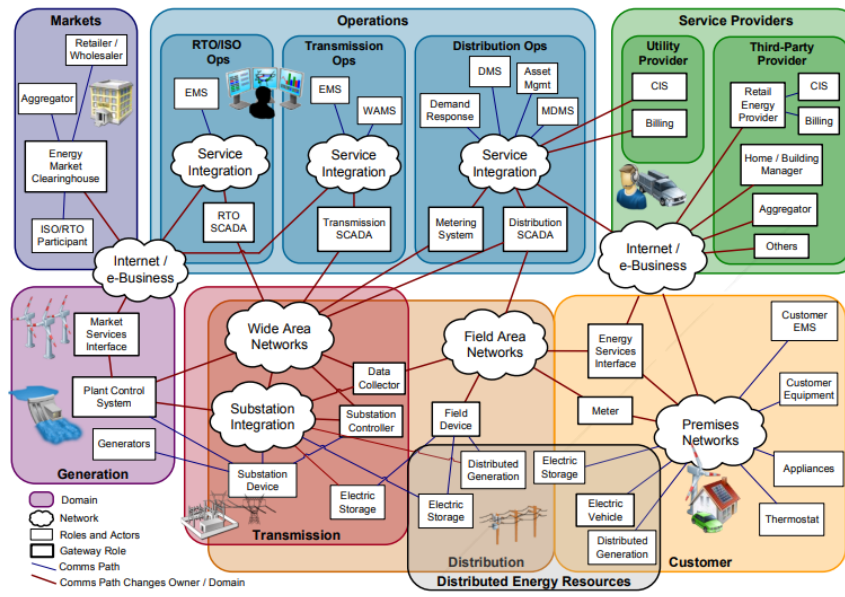
Figure 3. Mapping of legacy systems to conceptual domain